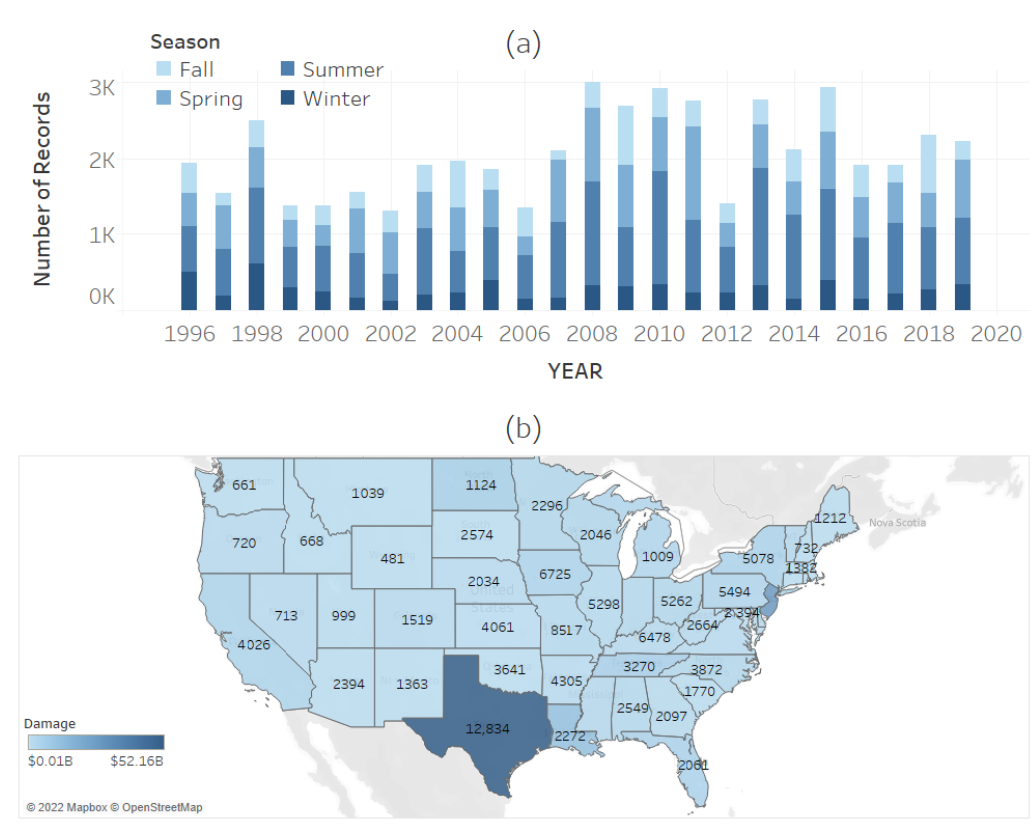
Figure 2. Descriptive spatio-temporal analysis of the employed dataset where ( a ) the annual number of floods between 1996 and 2019 indicated by season and ( b ) a multilayer spatial analysis of the dataset with the total number of records and the total damage in USD per state indicated by